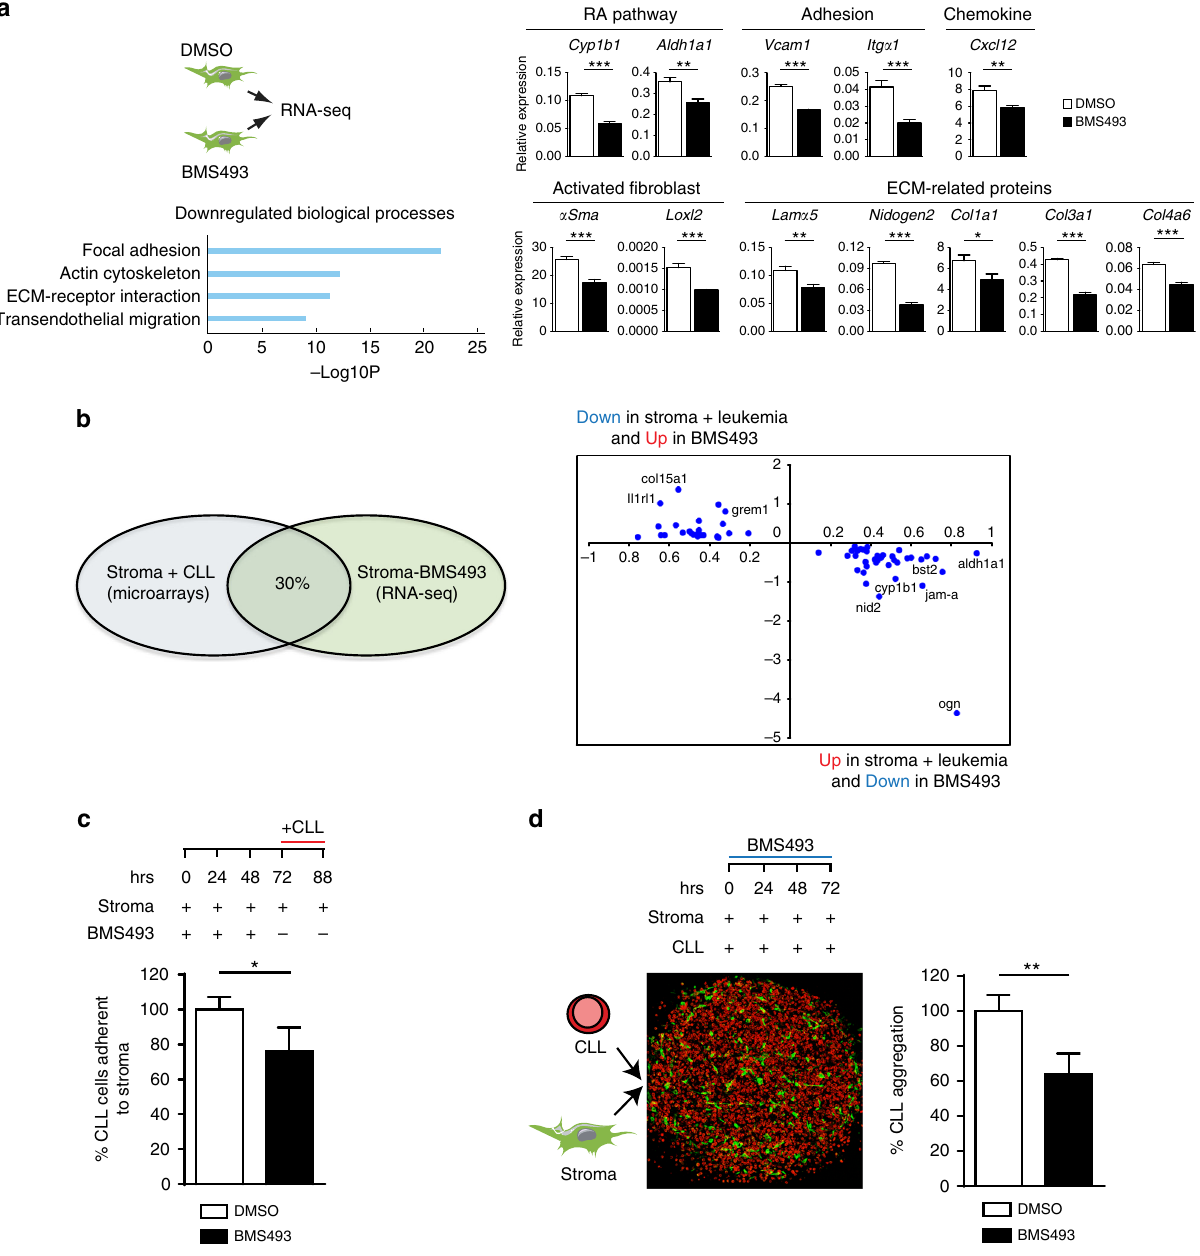
Fig. 2 Inhibition of the RA-signaling pathway in stromal cells affects multiple biological processes. a Experimental design of RNA-seq analysis performed on mRNA obtained from stromal cells treated with either vehicle (DMSO) or BMS493, and most down-regulated gene-signatures (bottom). Validation of mRNA expression levels of selected stromal gene-signatures after vehicle (DMSO) or BMS493 treatment. Data are representative of four independent experiments. The mean of triplicates and ±SD are shown, * p < 0.05, ** p < 0.01, *** p < 0.001. b Interpolation of gene expression pro fi les between microarray and RNA-seq data. c Quanti fi cation of murine E μ -TCL1 CLL cells adherence to stromal cells after BMS493 or vehicle (DMSO) treatment. Data are representative of three independent experiments with three different leukemia preparations. The mean of triplicates and ±SD are shown, * p < 0.05. d Aggregation of murine stroma (mSSC) and murine E μ -TCL1 CLL cells in spheroid assay. The percentage of aggregation results from the number of murine CLL cells that contribute to spheroid formation after treatment with BMS493 or vehicle (DMSO). Data are representative of one out of four independent experiments. The mean of triplicates and ±SD are shown, ** p <